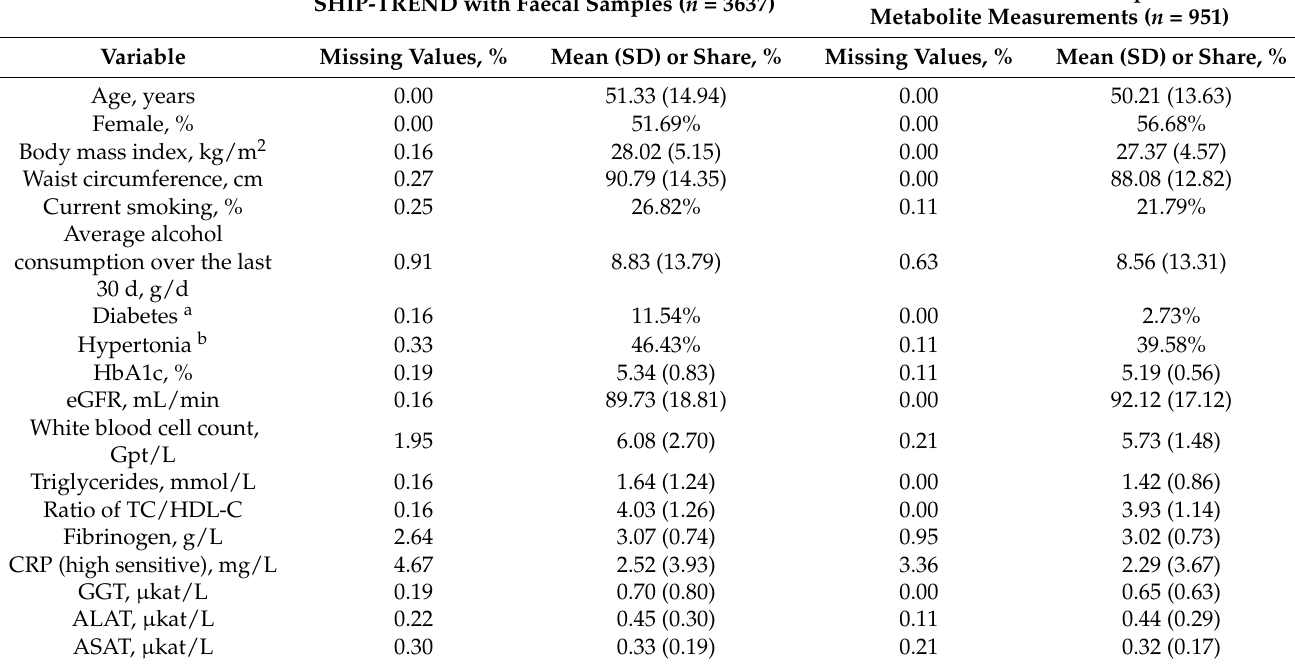
Table 1. Descriptive statistics for the utilised SHIP-TREND-0 sub-cohorts. SHIP-TREND with Faecal Samples and NMR SHIP-TREND with Faecal Samples ( n = 3637) Metabolite Measurements ( n =